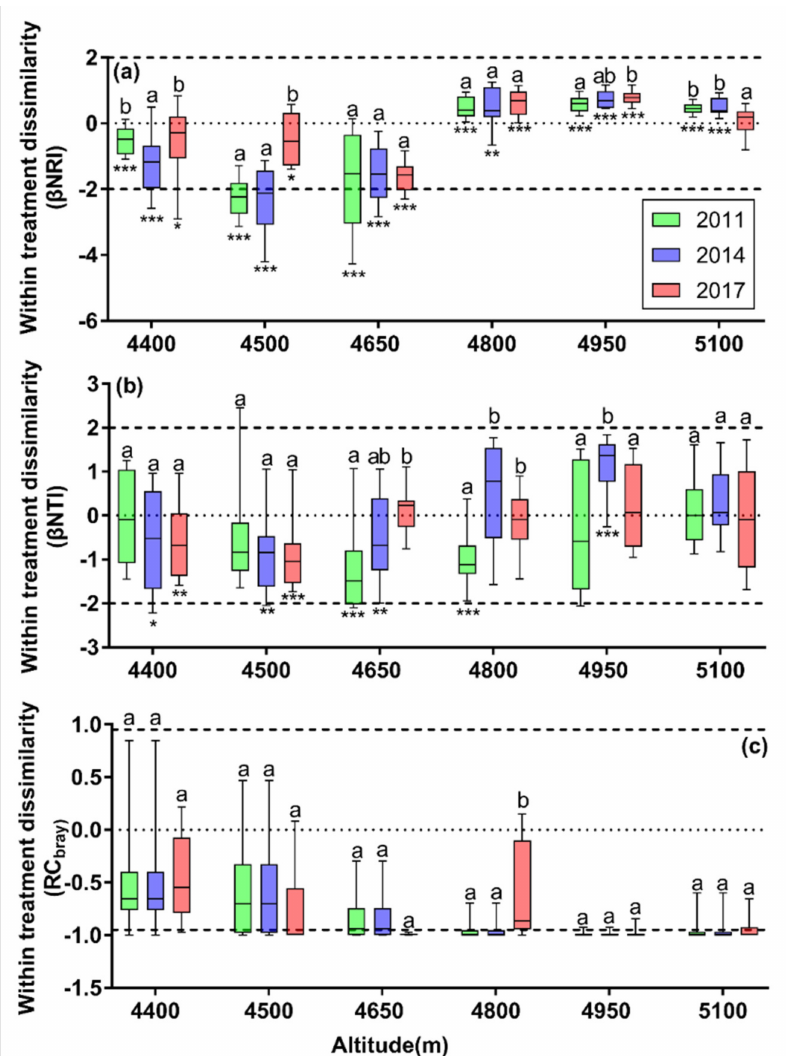
Figure 7. Effects of different types of grazing management on ( a ) net relatedness index based on β -diversity ( β NRI), ( b ) nearest taxon index based on β -diversity ( β NTI) and ( c ) Raup–Crick-based measure (RC Bray ) along the altitudinal gradient among different years. Dashed lines represent the threshold value of each index. Different letters indicate the significant differences (P < 0.05) among different years. Asterisk denotes values that are significantly different from zero based on one-sample t test. * P < 0.05, ** P < 0.01, *** P <